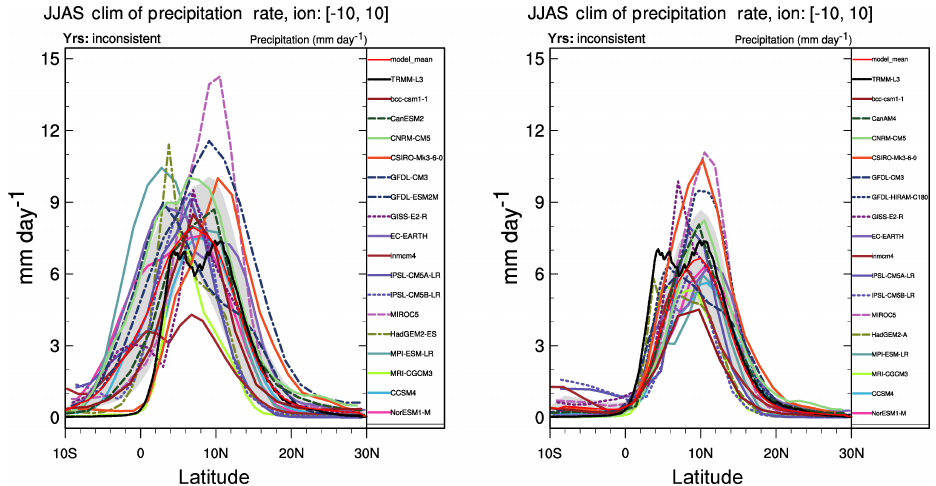
Figure 7. Precipitation (mmday − 1 ) averaged over 10 ◦ W–10 ◦ E for the JJAS season for the years 1979–2005 for CMIP5 historical simula- tions (left) and 1979–2008 for CMIP5 AMIP simulations (right) compared to 1998–2008 for TRMM 3B43 Version 7 data set. The results illustrate the inter-model spread in the mean position and intensity of the WAM among the CMIP5 models. The spread is slightly reduced in AMIP simulations, as the warm SST bias in the equatorial Atlantic is removed. The WAM mean structure, however, is not captured by many models. Produced with namelist_WAMonsoon.xml